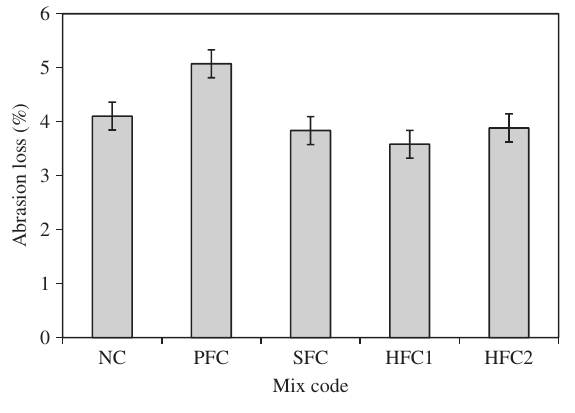
Figure 7 Abrasion loss in concrete series after